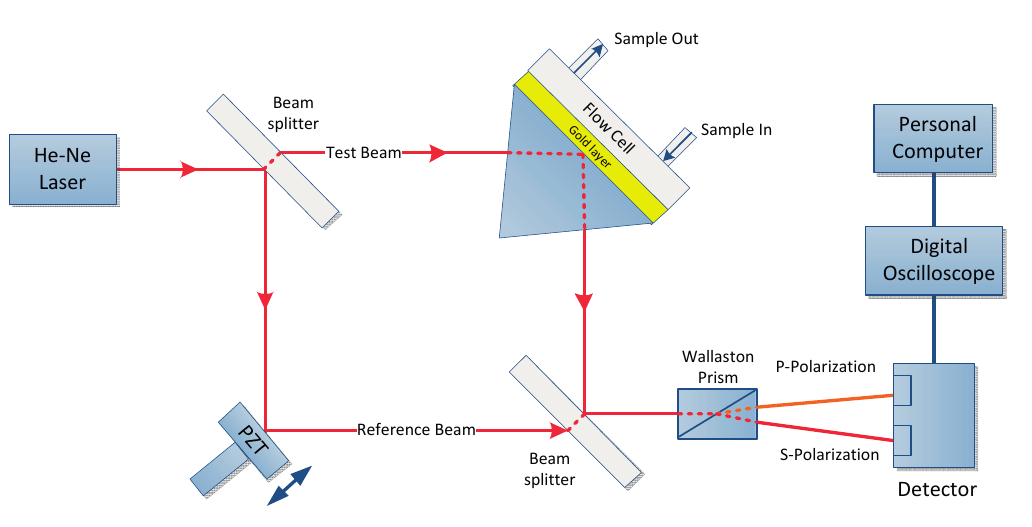
Figure 5. Experimental setup used to measurement the differential SPR phase shift representing s- and p-polarizations [69].